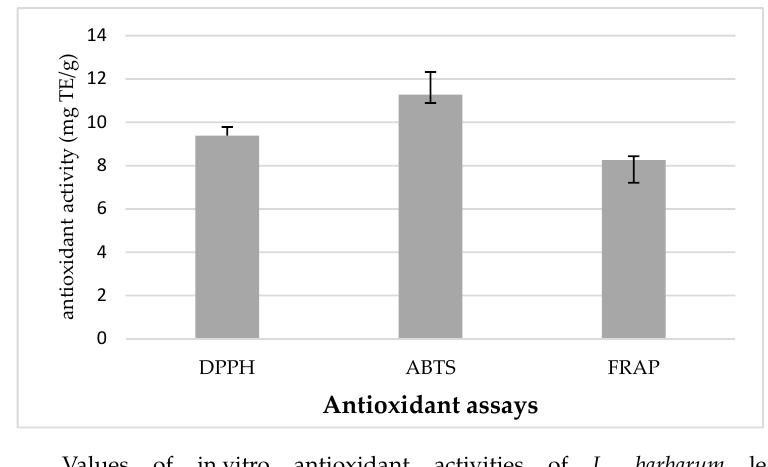
Figure 1 . Values of in vitro antioxidant activities of L. barbarum leaf extracts, evaluated by DPPH, Figure 1. Values of in vitro antioxidant activities of L. barbarum leaf extracts, ABTS, and FRAP assays. The error bars represent the standard deviation (n = 3). DPPH, 2,2 ‐ diphenyl ‐ evaluated by DPPH, ABTS, and FRAP assays. The error bars represent the 1 ‐ picrylhydrazyl; ABTS, diammonium 2,2’ ‐ azino ‐ bis(3 ‐ ethylbenzothiazoline ‐ 6 ‐ sulphonate), FRAP, standard deviation (n = 3). DPPH, 2,2-diphenyl-1-picrylhydrazyl; ABTS, diammonium ferric reducing antioxidant power. 2,2’-azino-bis(3-ethylbenzothiazoline-6-sulphonate), FRAP, ferric reducing antioxidant